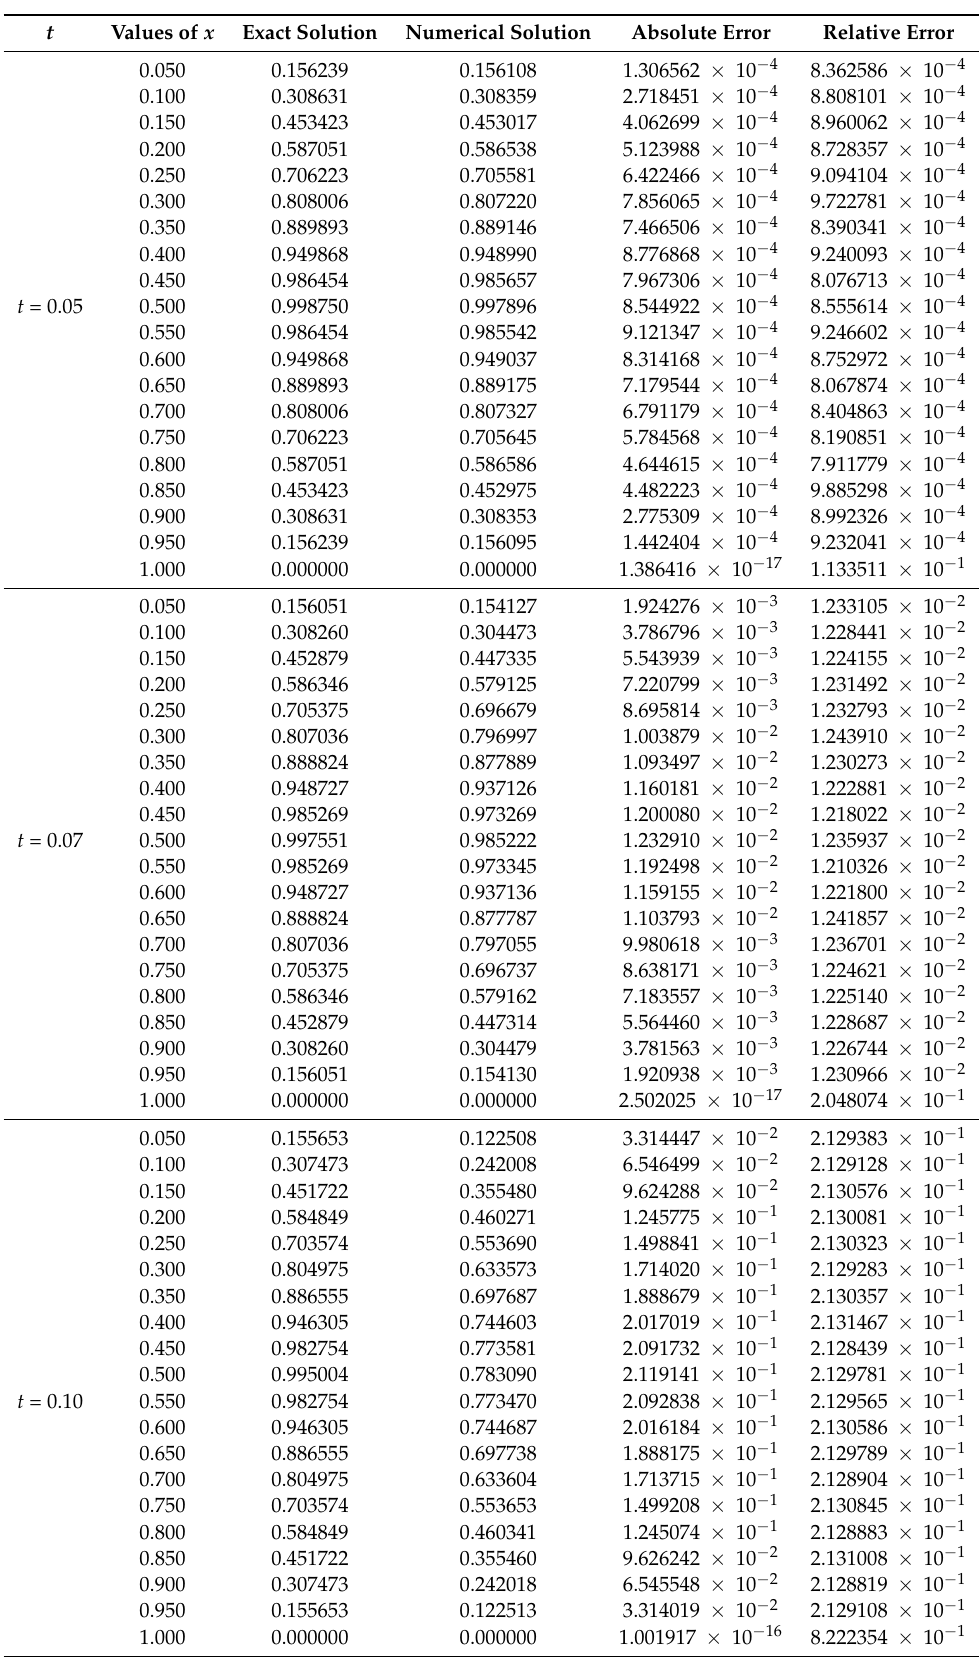
Table 2. Absolute and relative errors at some values of x obtained at times 0.05, 0.07, 0.10 using 7-terms of LADM (for numerical experiment